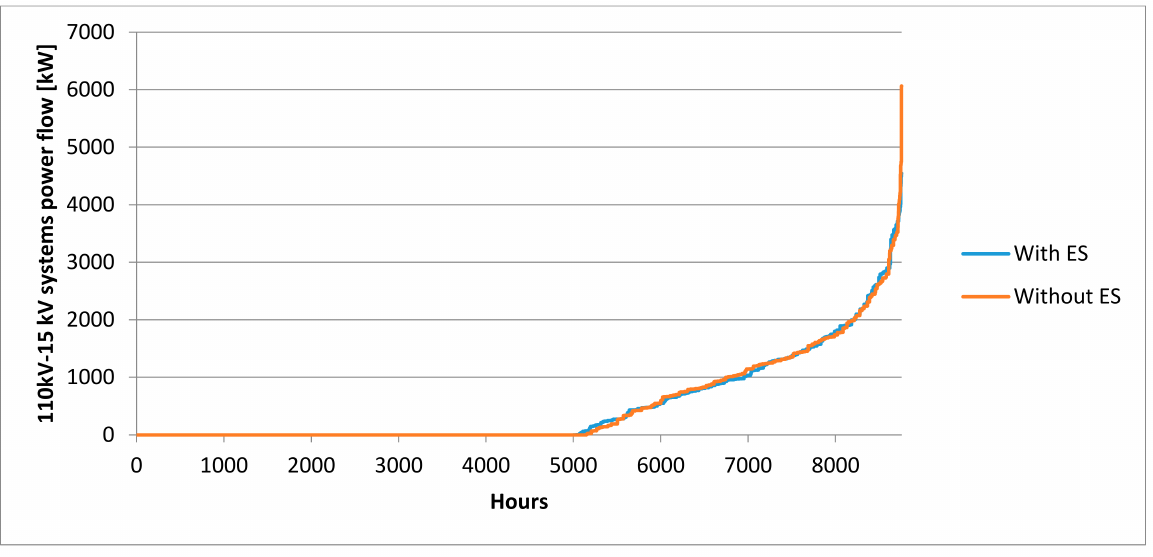
Figure A6. TSO-DSO power flow with and without ES for 90% energy from